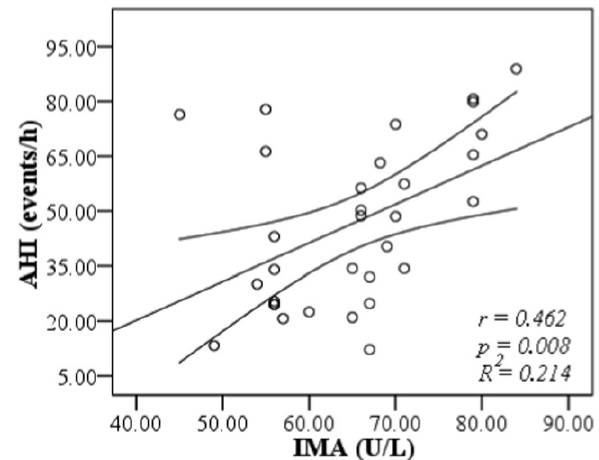
Figure 1 - Changes in the serum butyrylcholinesterase activity and ischemia-modified albumin levels in nine obstructive sleep apnea patients at baseline and after treatment with continuous positive airway pressure.